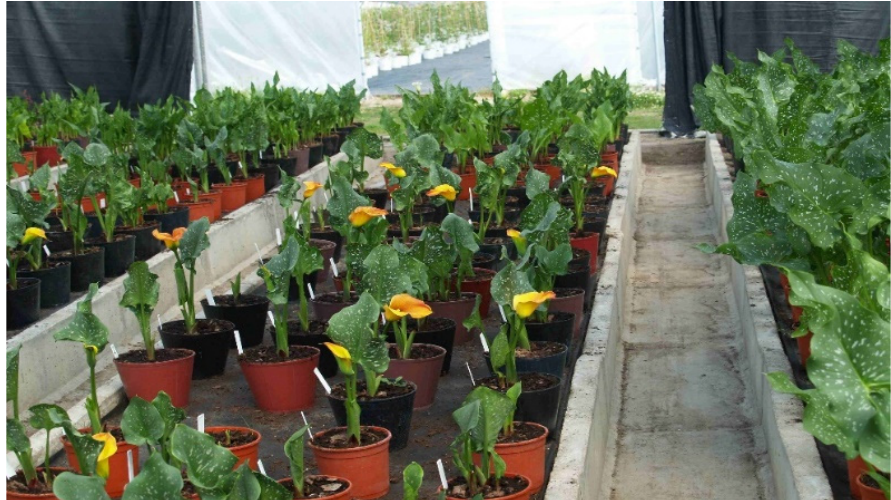
Figure 2. Beginning of flowering ‘Mango’ cultivar grown in plastic tunnel (Beata Janowska 2010).